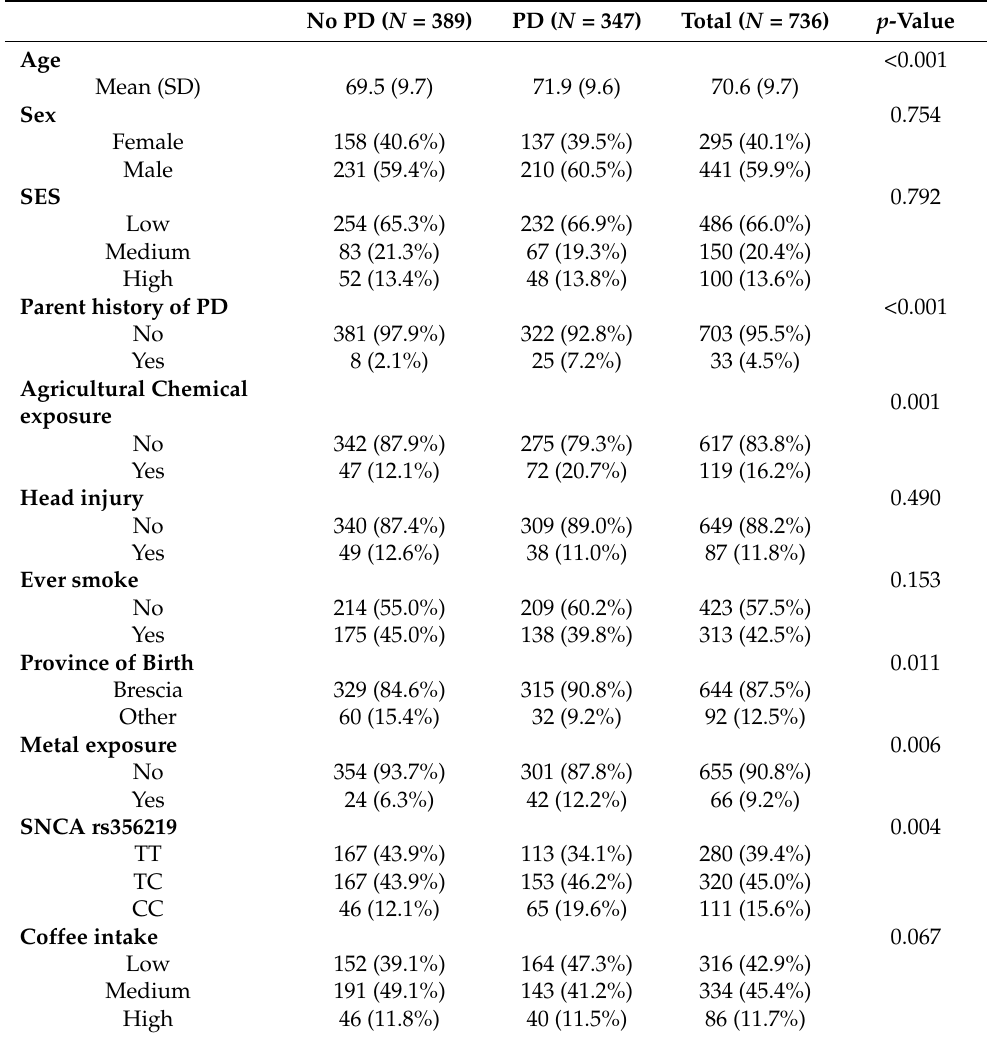
Table 1. Characteristics distribution of the overall population and divided by participants with and without PD. p -value of t -test and chi-squared test were included to test the difference between No PD and PD groups for continuous and categorical